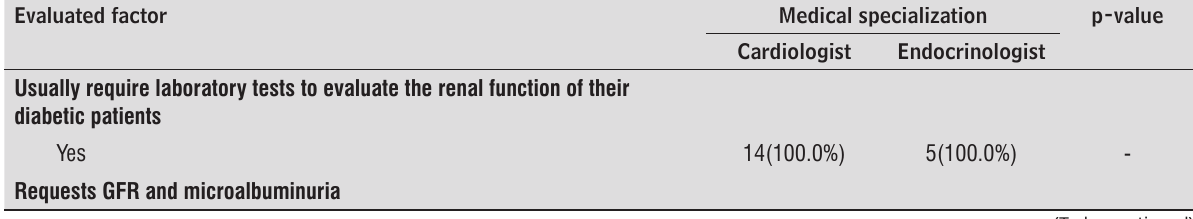
Table 2 - Characteristics regarding the evaluation of renal function between cardiologists and endocrinologists Evaluated